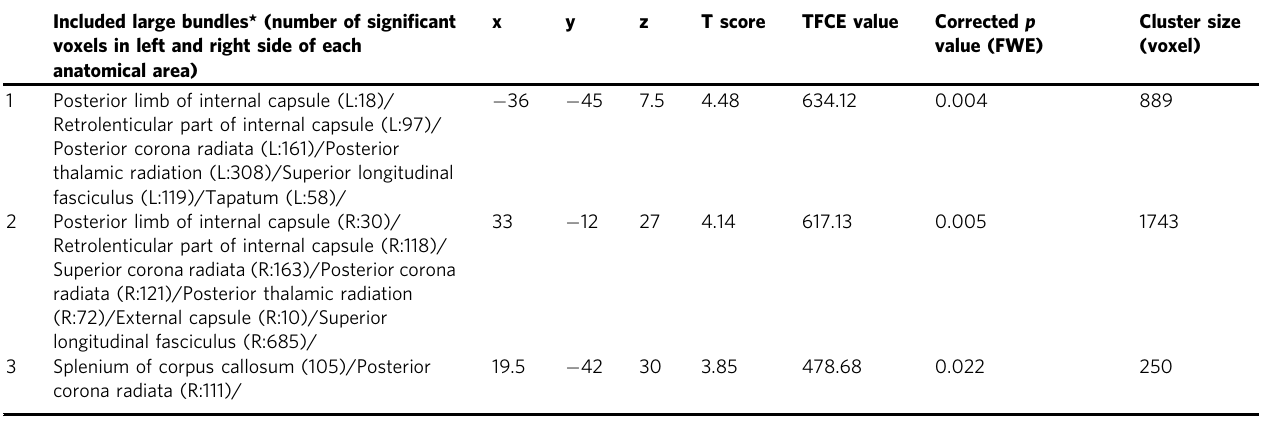
Table 3 Brain regions with signi fi cant associations between greater hair mercury levels and greater fractional anisotropy. Included large bundles* (number of signi fi cant voxels in left and right side of each anatomical area) Posterior limb of internal capsule (L:18)/ Retrolenticular part of internal capsule (L:97)/ Posterior corona radiata (L:161)/Posterior thalamic radiation (L:308)/Superior longitudinal fasciculus (L:119)/Tapatum (L:58)/ Posterior limb of internal capsule (R:30)/ Retrolenticular part of internal capsule